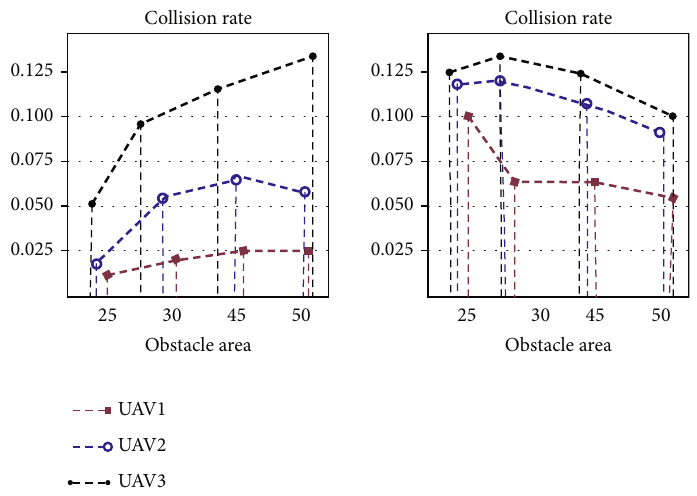
Figure 3: Working collision rate and mission success rate of